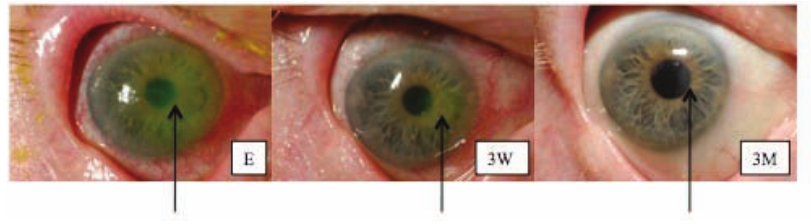
Figure 1. Photographs of the infected eye taken on the first day of treatment (E), after 3 weeks (3W), and after 3 months of follow-up (3M). The arrow indicates the site of the ulcer (E and 3W) and the scar (3M). Please note that the yellow-green coloration of the ulcer in photograph E is due to fluorescein drops used during examination of the patient's cornea. Staining with fluorescein indicates disruption of the corneal epithelium. Staining with fluorescein indicates disruption of the corneal